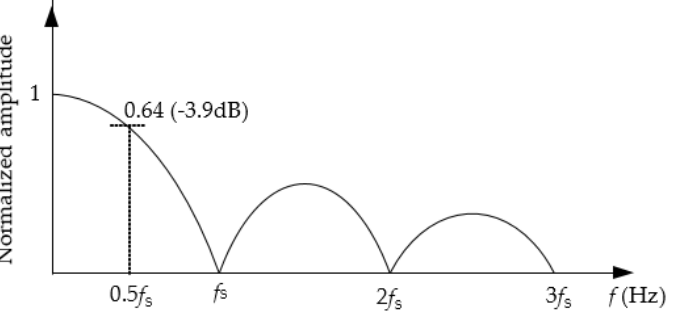
Figure 4. Normalized frequency response of the DIC when measuring a resistive sensor with sinusoidal changes at f .